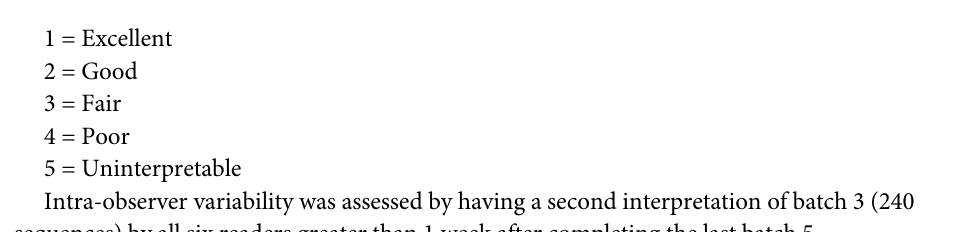
Fig 1. Schematic of image distribution and labeling into the 5 reading batches. Six different MR sequences for each patient were moved into 5 separate reading batches. In any one batch, the same carotid birfurcation was not seen twice.